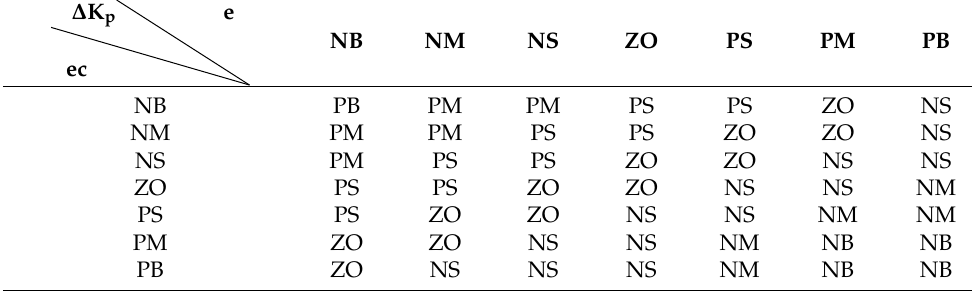
Table 3. The integral coefficient fuzzy control rule table is listed in Table 4. The differential coefficient fuzzy control rule table is listed in Table 5. Table 3. ∆ K p Fuzzy control rule table.